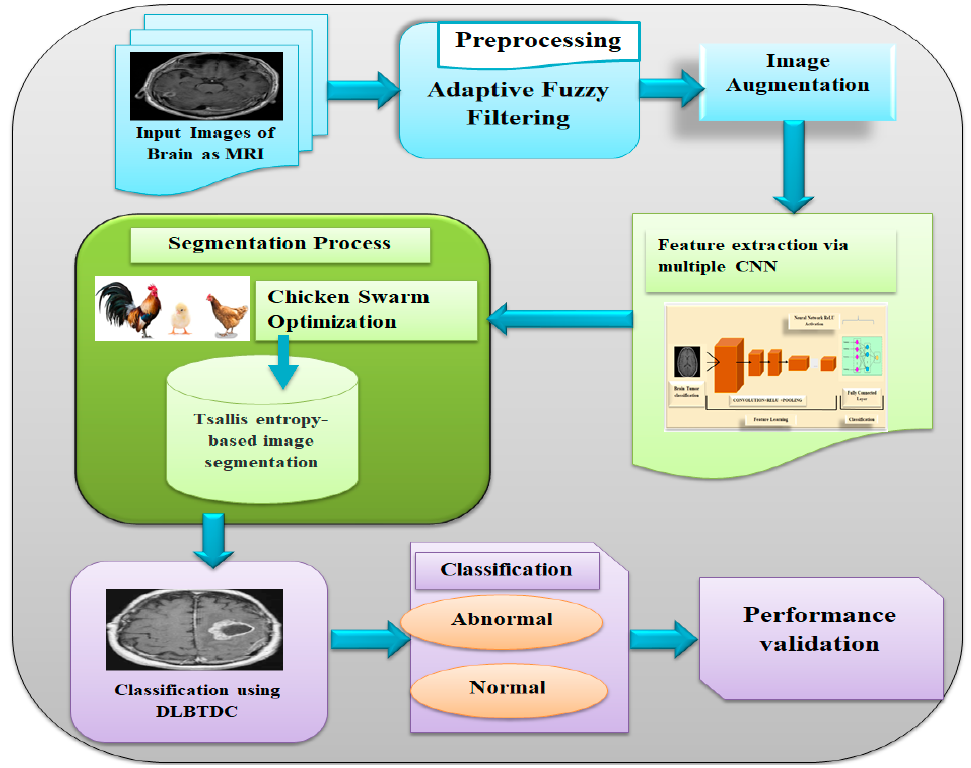
Figure 1. Proposed diagram for DLBTDC-MRI.